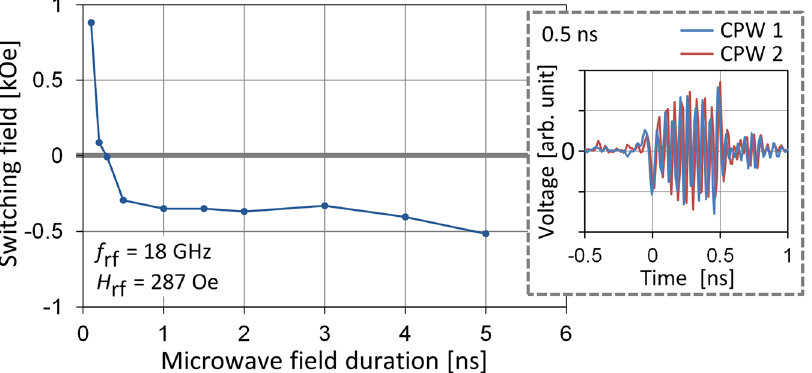
Figure 4. H versus microwave field duration in the circularly polarized microwave field from CPWs 1 and 2 sw for = f 18 GHz and = H 287 Oe. The inset shows a waveform of signals with a zero rise/fall time and a 0.5- rf rf ns plateau time measured at the cable end connected to the